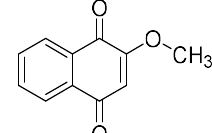
Figure 1. 2-Methoxy-1,4-naphthoquinone (MNQ).